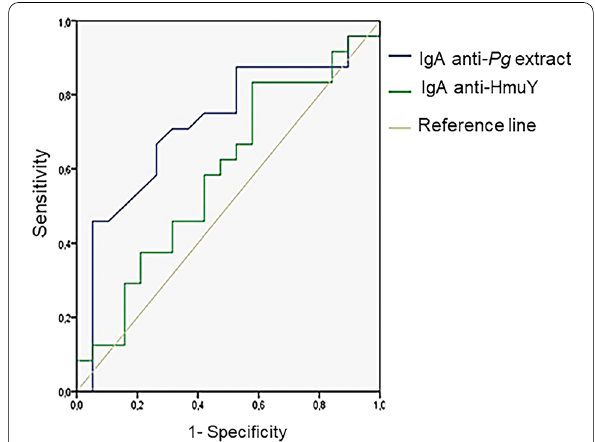
Fig. 2 ROC curve constructed with the OD triplicate averages obtained for each sample. In blue, the curve for the P. gingivalis crude extract antigen: area under the curve cut‑off 0.134, sensitivity curve for HmuY antigen: area under the curve 0.41–0.76, cut‑off